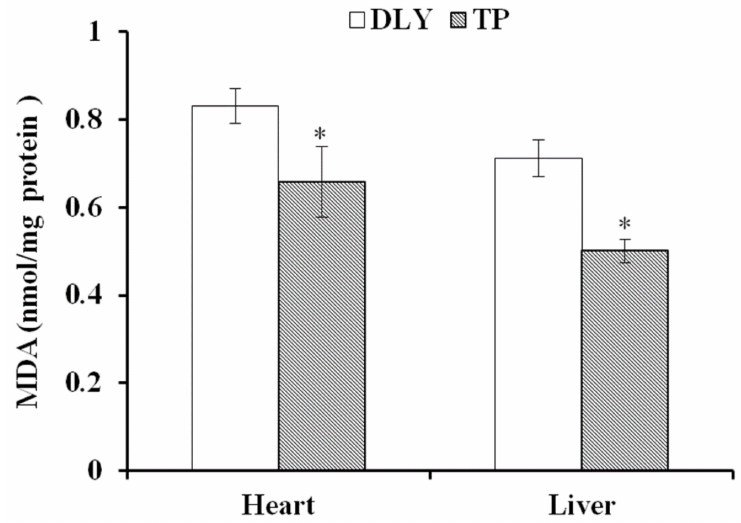
Figure 1. Effects of the plateau environment on MDA in heart and liver of TPs and DLY pigs ( n = 12). * Significant difference ( p < 0.05). MDA = malondialdehyde.